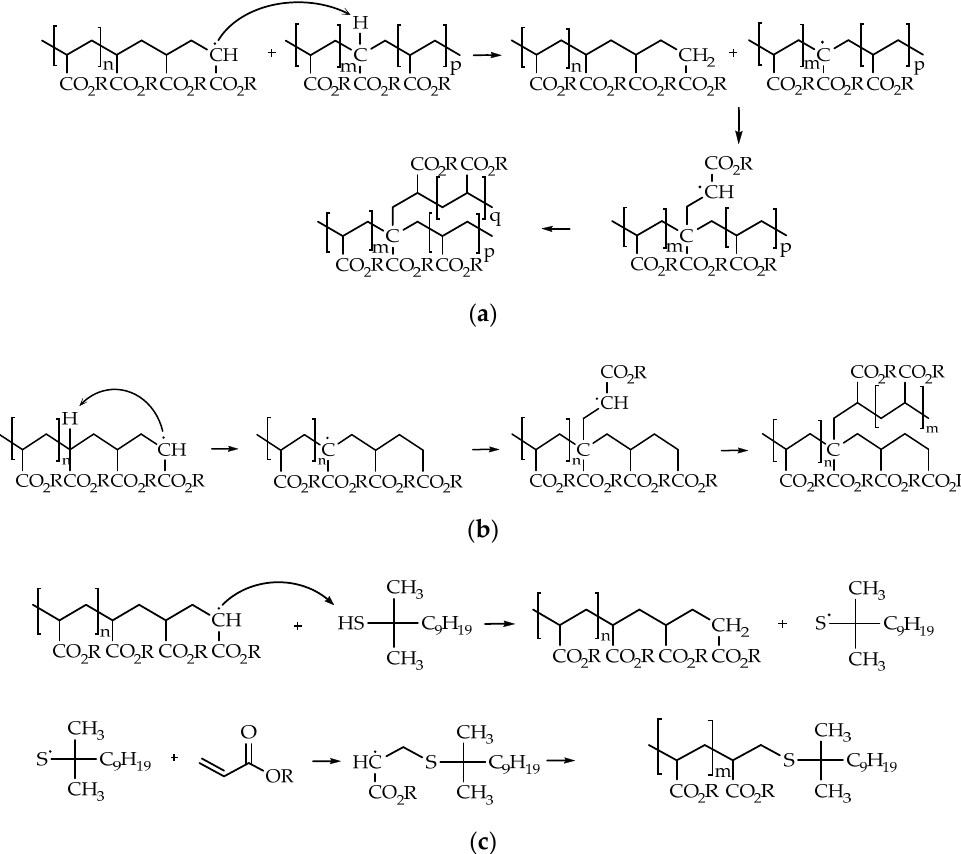
Figure 4. Mechanisms proposed for transfer to polymer reactions: ( a ) Intermolecular chain transfer to polymer. ( b ) Intramolecular chain transfer to polymer (backbiting). ( c ) Chain transfer to tert-dodecyl mercaptan.